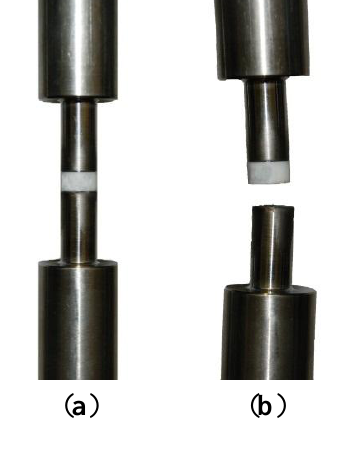
Figure 1. ( a ) Setup for adhesive strength test sample prior to testing; ( b ) Sample after